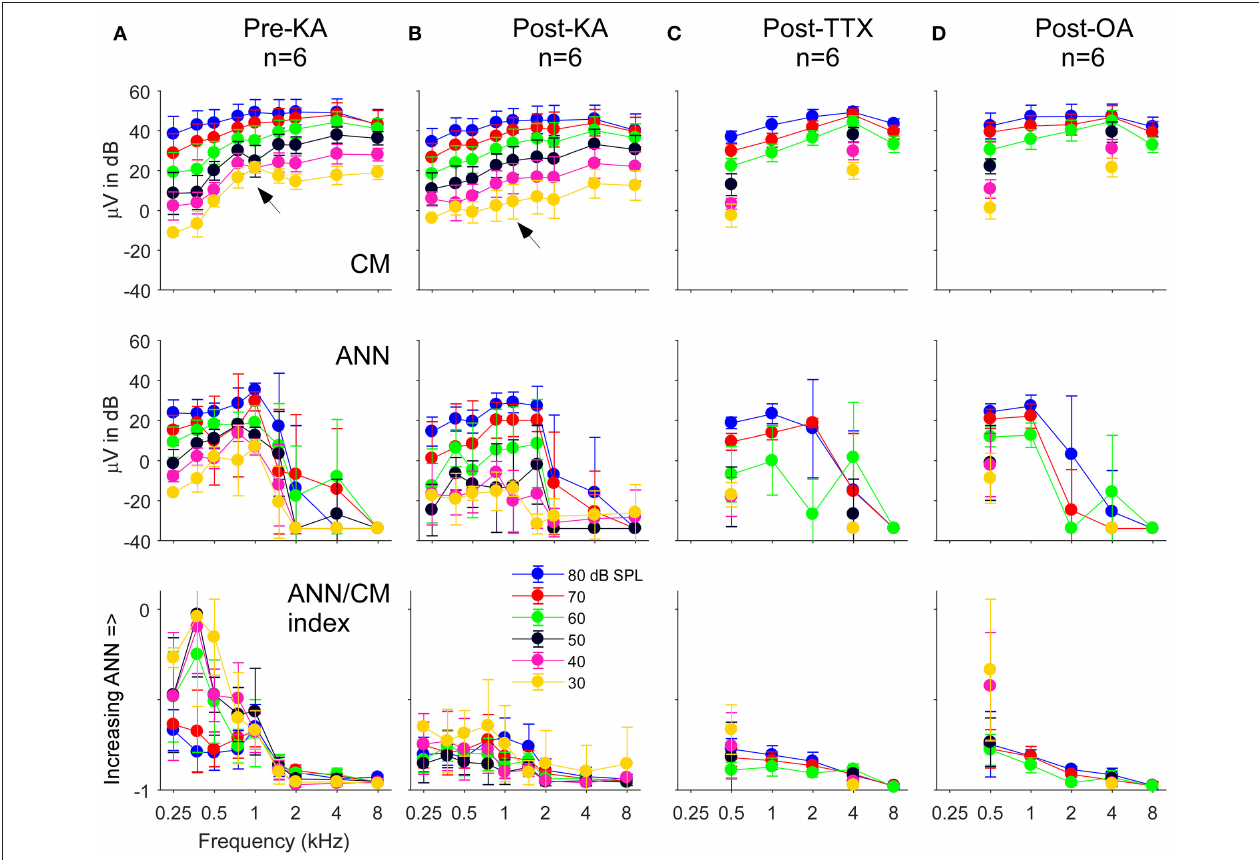
FIGURE 8 | The CM, ANN, and ANN/CM index reported by the model as functions of frequency and intensity. (A) The Pre-KA condition. The CM shows an orderly pattern of CM across frequency and intensity, with no cut-off to higher frequencies. The arrow represents a small discontinuity to low frequencies (750 and 1,000Hz) and intensities (30–50 dB SPL). The ANN shows a low-pass cut-off to frequencies > 1,000Hz. However, a non-linearity was introduced—all responses where the ANN/CM ratio was < 5% were considered no response (see Text for further explanation). The ANN/CM index, where no non-linearity was introduced, also showed the low pass cut-off to frequencies > 1,000Hz. (B–D) Responses after KA, TTX, and OA, respectively. The Pre-Drug condition for TTX and OA are not shown, but were similar to that for Pre-KA. A smaller range of frequencies and intensities was tested with TTX and OA that with KA. In general, the CM was little affected by the neurotoxin. However, the discontinuity seen in the CM was not present after KA (arrow). The ANN/CM index was also reduced to low intensities, but was already small at high intensities so a change was difficult to detect. The reduction in the ANN and ANN/CM index was greater for KA and TTX than OA. Errors bars are standard